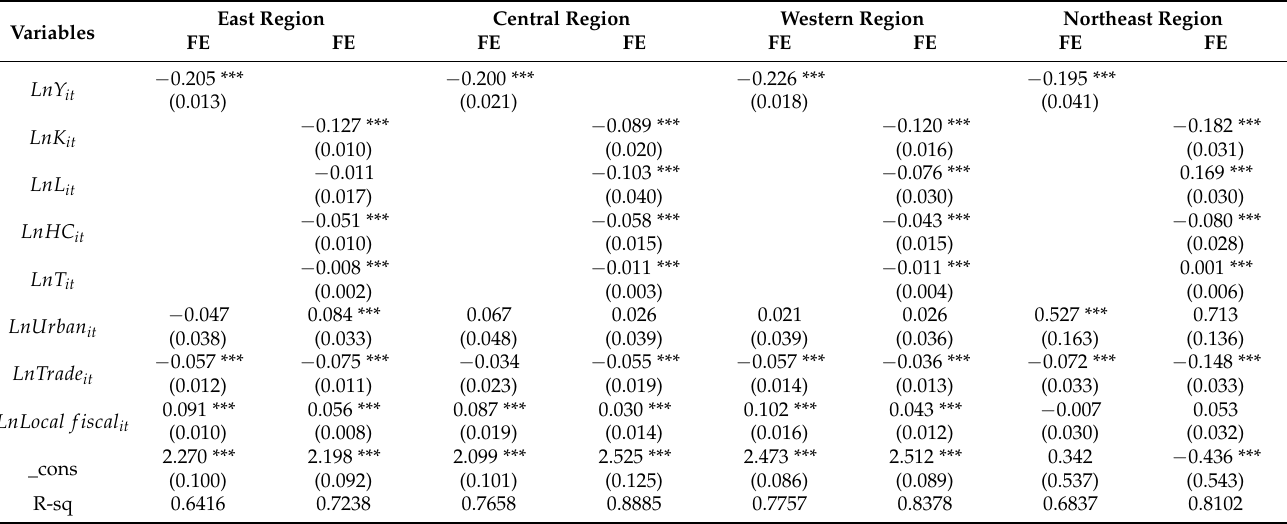
Table 5. Regional difference analysis—the poverty reduction effects of the agricultural products circulation industry and its internal development